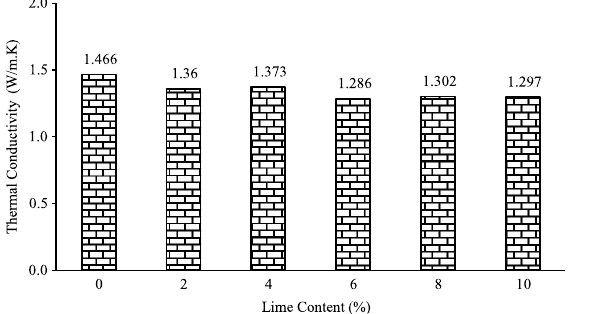
FIG.10. CLAYEY SAMPLE MIXED WITH LIME